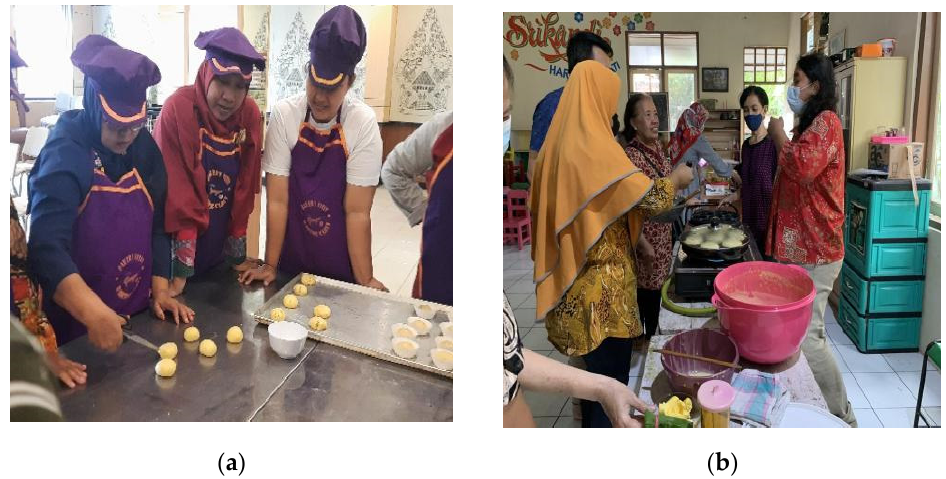
Figure 2. ( a ) Baking training at Ganep bakery; ( b ) training on making apem Kampung Sewu.